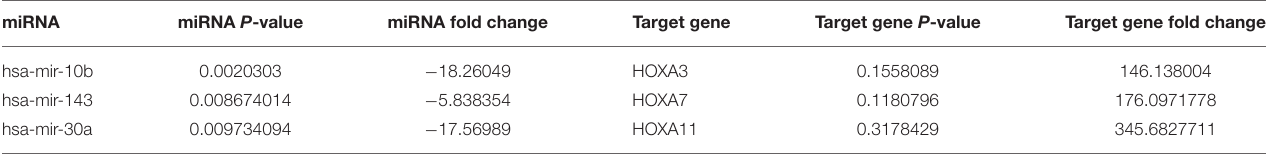
TABLE 3 | miRTarVis + integrative mRNA-miRNA analysis of three significantly differentially expressed miRNAs and the fold change of the corresponding target mRNA. miRNA miRNA P -value miRNA fold change Target gene Target gene P -value Target gene fold